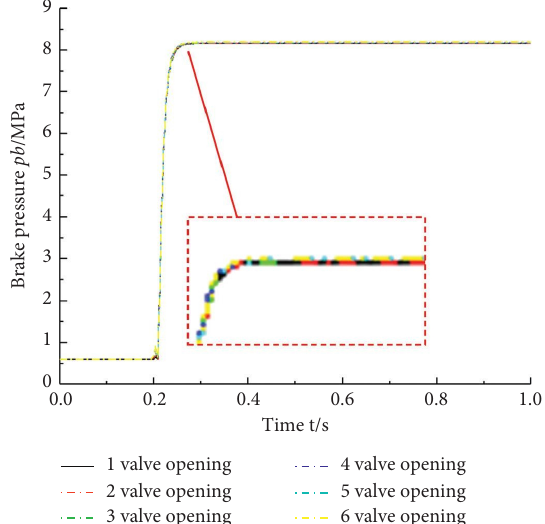
Figure 14: Pressure output of two-stage brake pressure servo valve with multiple valves in parallel at 15MPa oil supply.